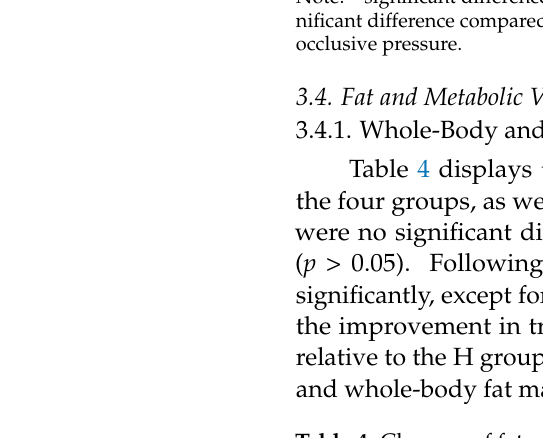
Table 4. Changes of fat variables in each